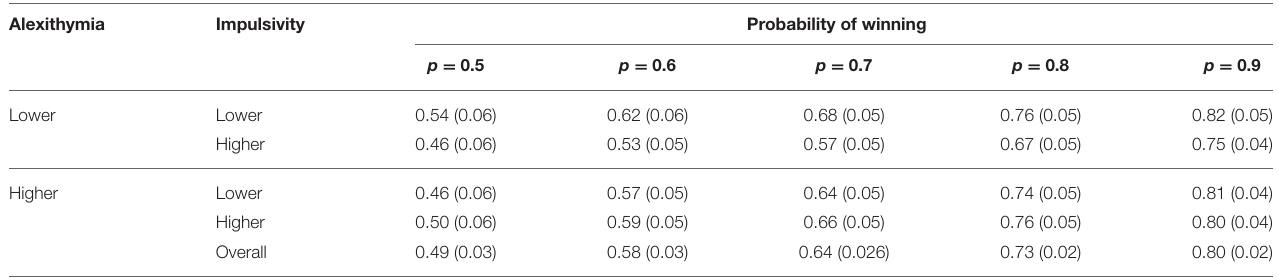
TABLE 6 | Means (and standard errors) of the proportion bet by alexithymia and impulsivity by probability of winning on the current trial. Alexithymia